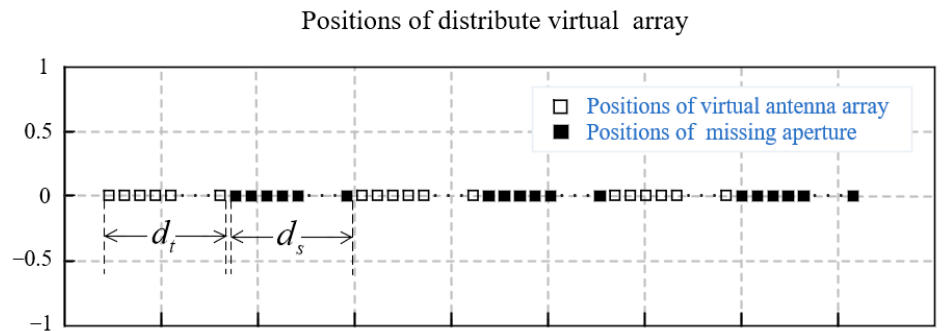
Figure 2. The virtual array of the distributed FMCW MIMO radar system, with 86 virtual elements in d t and 86 missing virtual elements in d s